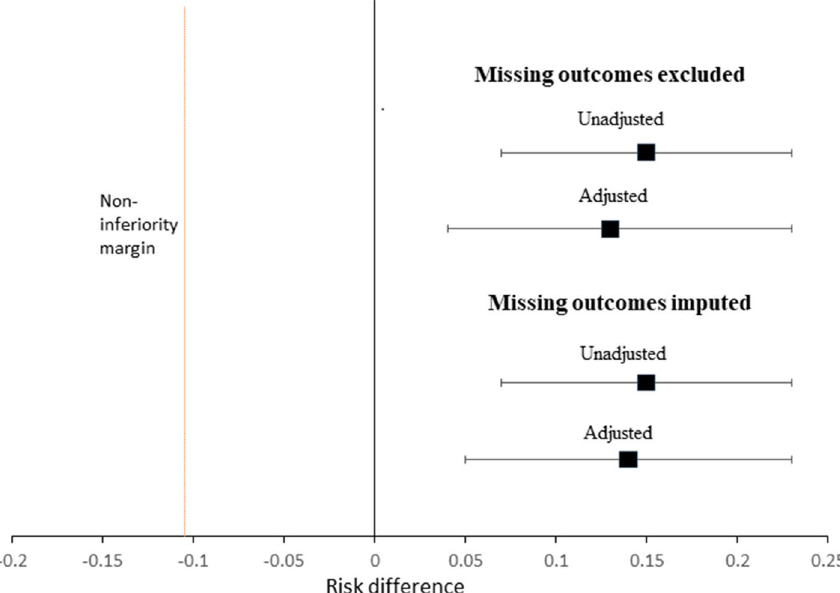
Figure 1. Assessment of non-inferiority based on cure rate. The risk difference (RD) is adjusted for wealth index, exposure to HIV, and fever at baseline. The error bars represent 95% CIs around the point estimate (black